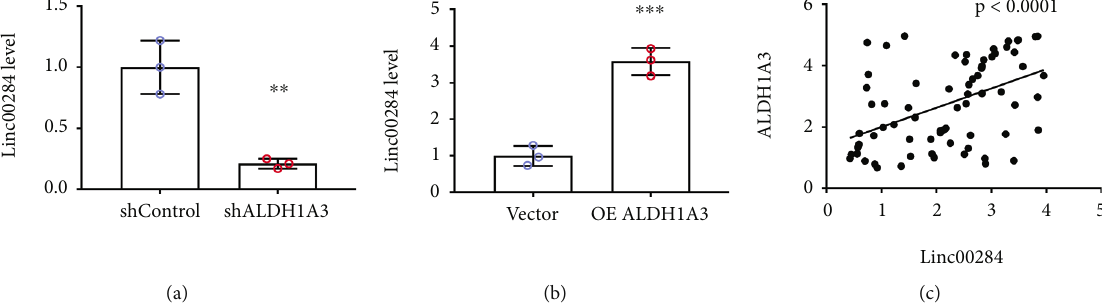
Figure 3: ALDH1A3 mediated the expression of Linc00284 in vitro and in CRC tissues of patients. The expression of Linc00284 in ALDH1A3-silenced (a) and -overexpressed (b) SW480 cells was determined by qPCR analysis. (c) The correlation between ALDH1A3 and Linc00284 was analyzed by Pearson correlation test in 73 human CRC